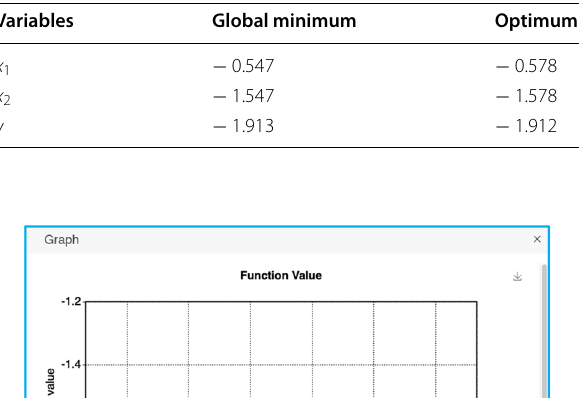
Table 2 The optimum solution provided by DADOS for the numerical example